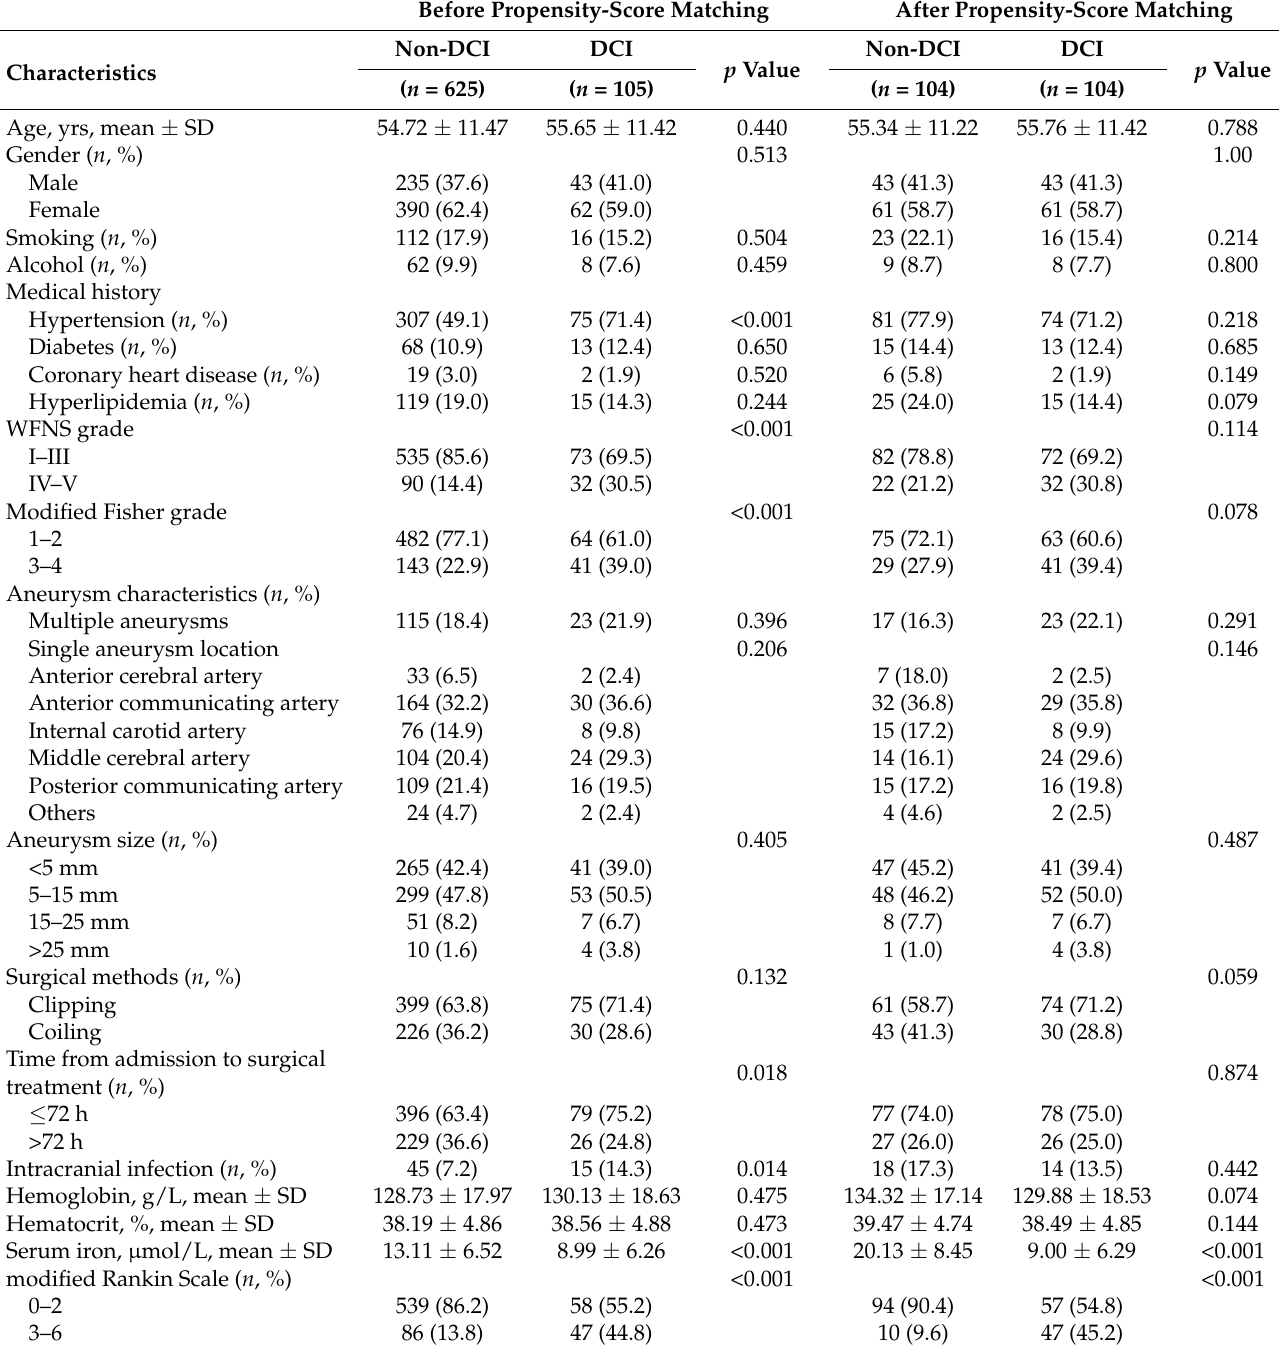
Table 1. Univariate analysis of association with DCI before and after propensity-score matching. Before Propensity-Score